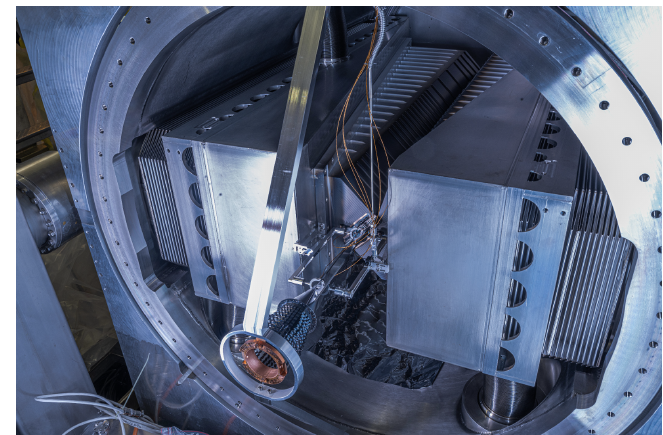
Figure 2. Storage cell installed and connected to the VELO